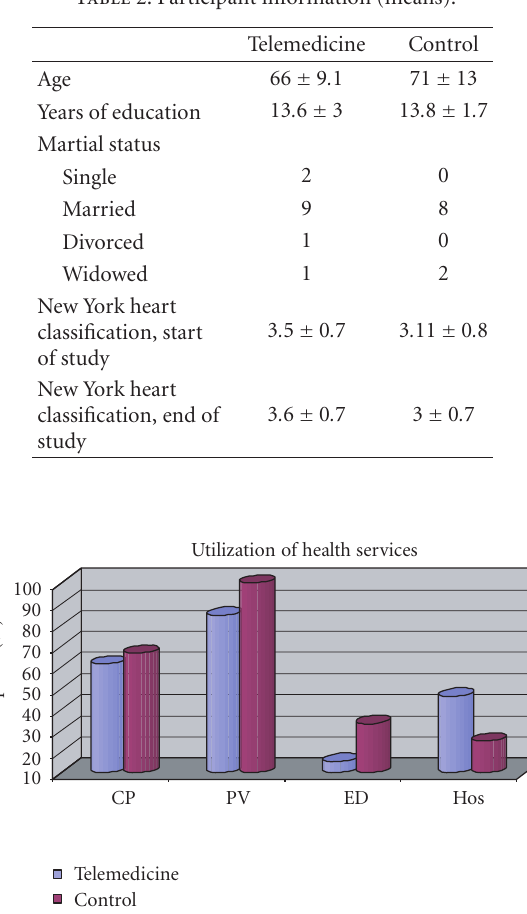
Table 2: Participant information (means).